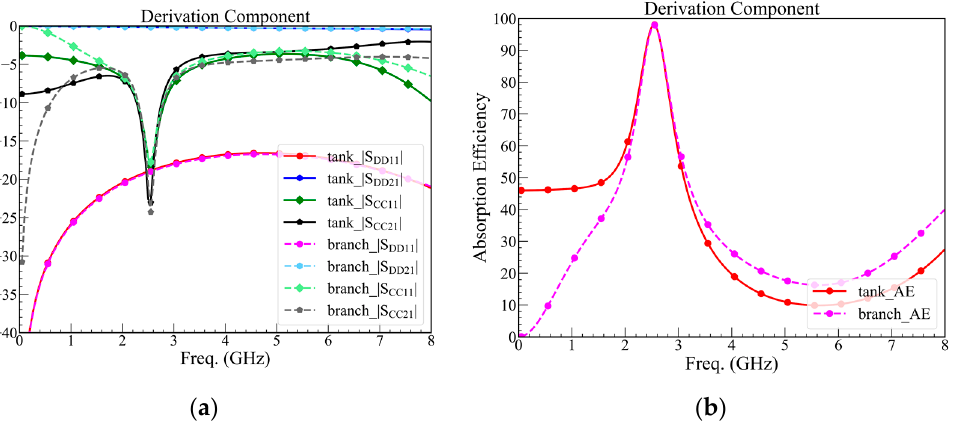
Figure 8. ( a ) Mixed-mode S -parameters of the proposed design with derivation components, and ( b ) absorption efficiency of the proposed design with derivation components.